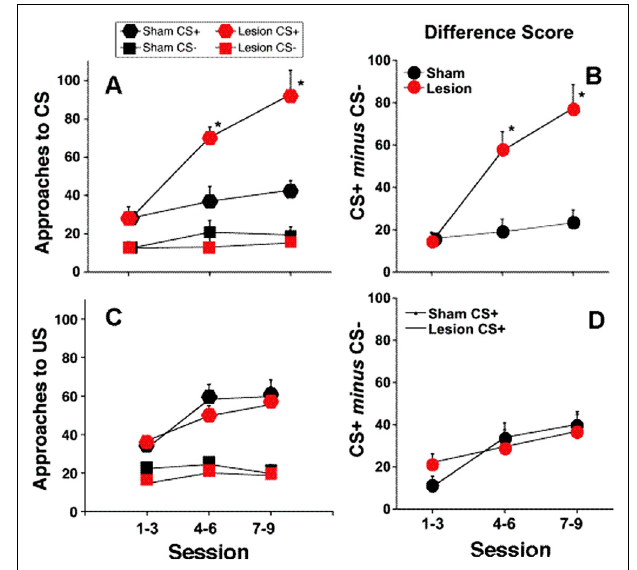
FIGURE 1 | Full contrast conditioning schedule. (A–D) represent the effects of fr lesions on conditioned approach to each CS (A) and to the US (C) during the CS + and CS − presentation. (B,D) represent the difference scores (CS + minus CS − ) derived from values represented in (A,C) . n = 10 and 8 for the Sham and Lesion groups, respectively. Error bars represent S.E.M. * p <